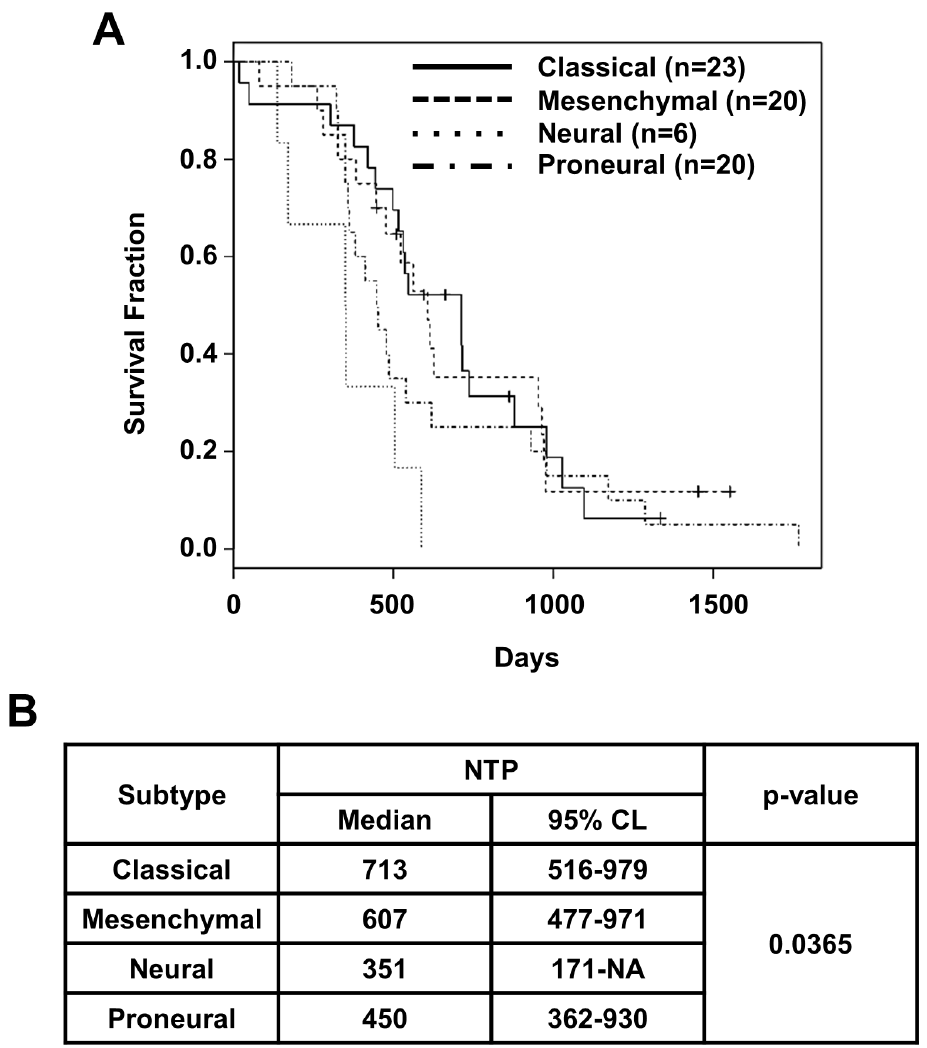
Figure 3. Prognostic outcomes of 4 molecular subtypes of 105 SMC GBM patients. ( A ) Kaplan Meier plot shows survivals for 4 molecular subtypes of 105 SMC GBM patients, which was predicted by the NTP method. ( B ) Median overall survival lengths (Median) and 95% confidence limits (CL) of the subtypes were summarized. Log rank test was used for statistical analyses.